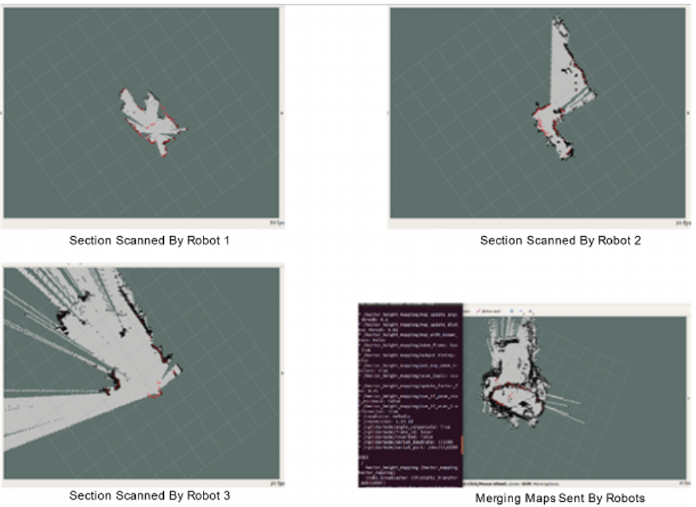
Figure 15. Maps Created as a Result of Simulation. After the maps were created, they were merged by the Radon transform algorithm. Radon transformation is used to extract geometric information from a map according to offsets and rotation [39]. Sinogram-based map aggregation was performed using Radon transform. Sinogram-based map assembly consists of two consecutive parts, as shown in Figure